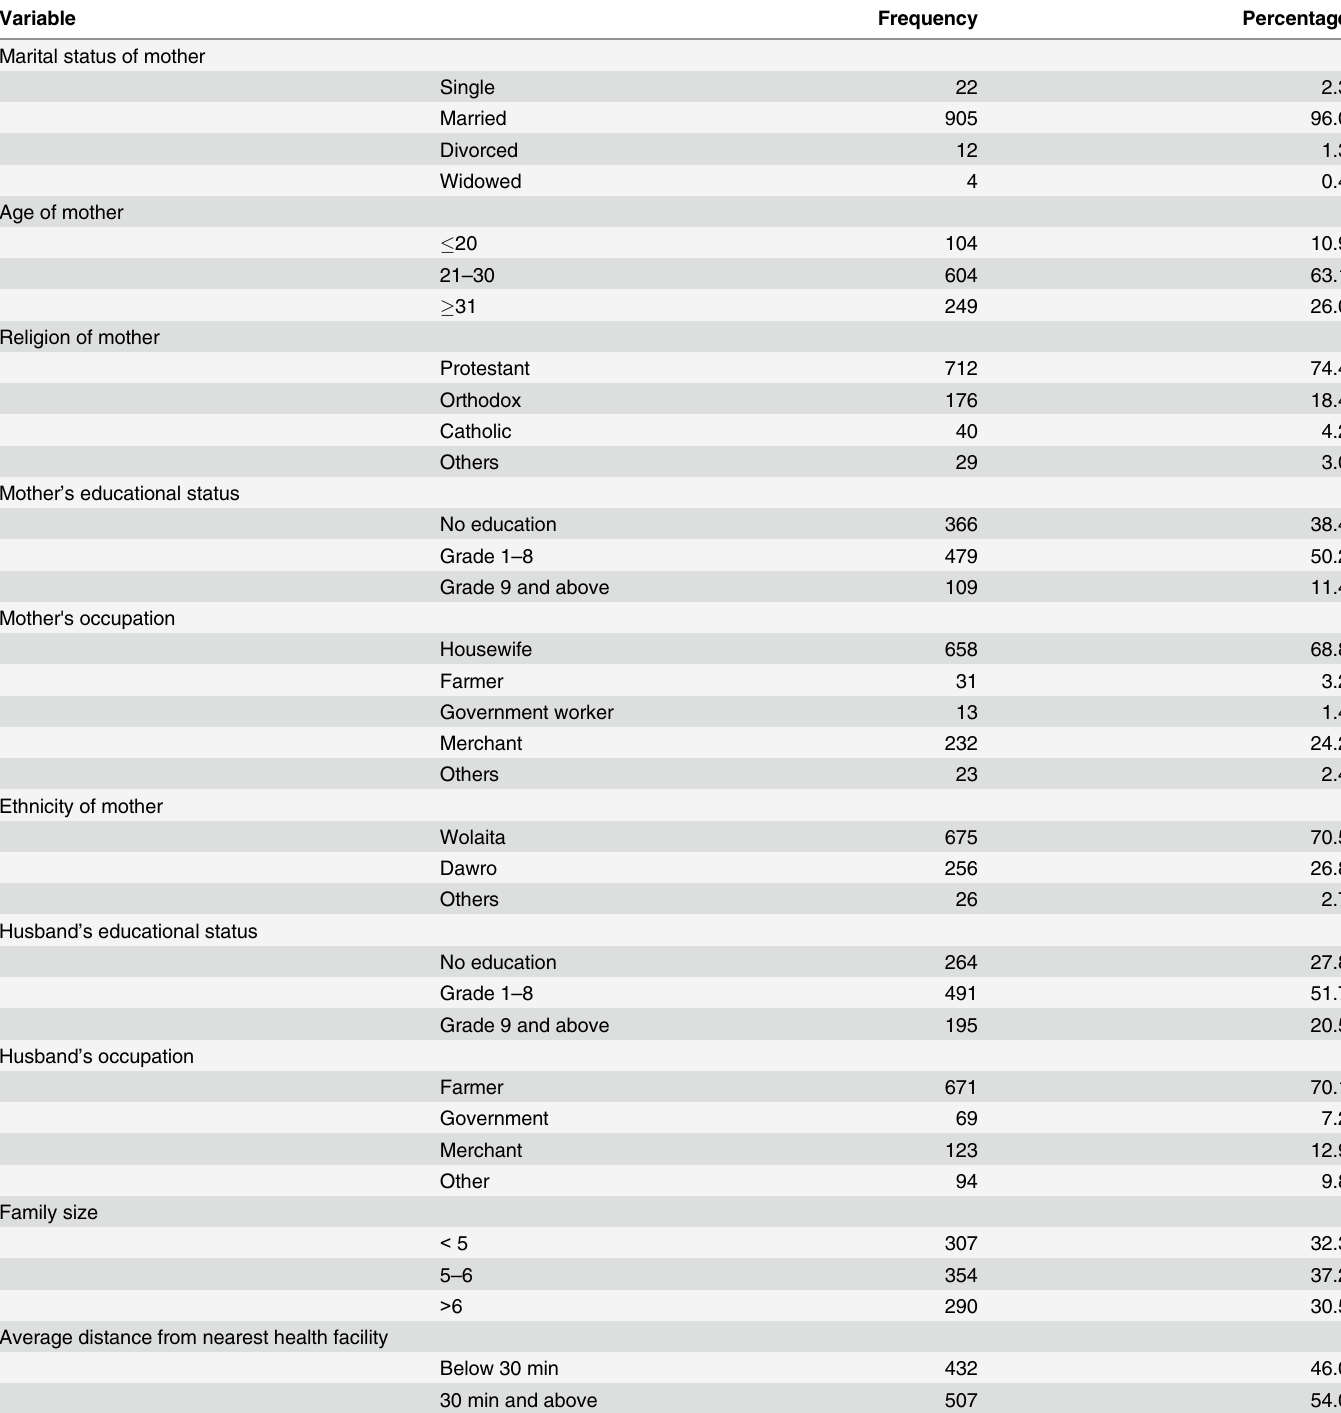
Table 1. Socio-demographic characteristics of study participants, assessment of institutional delivery service utilization in Wolaita and Dawro zone, 2015.